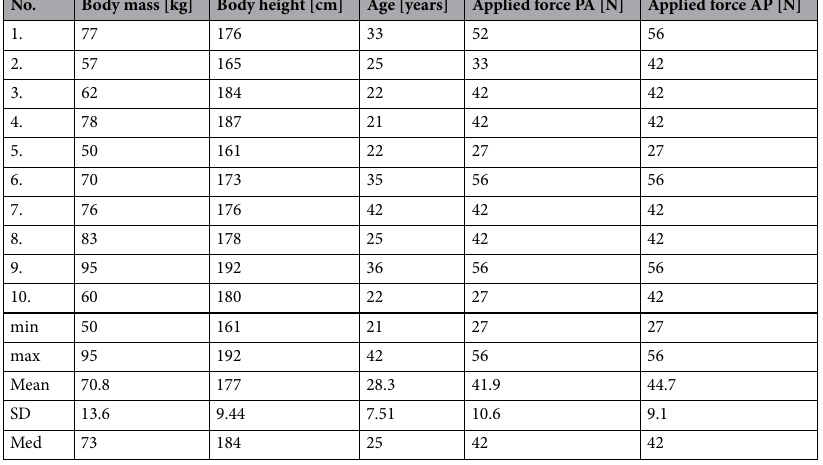
Table 3. Parameters of the